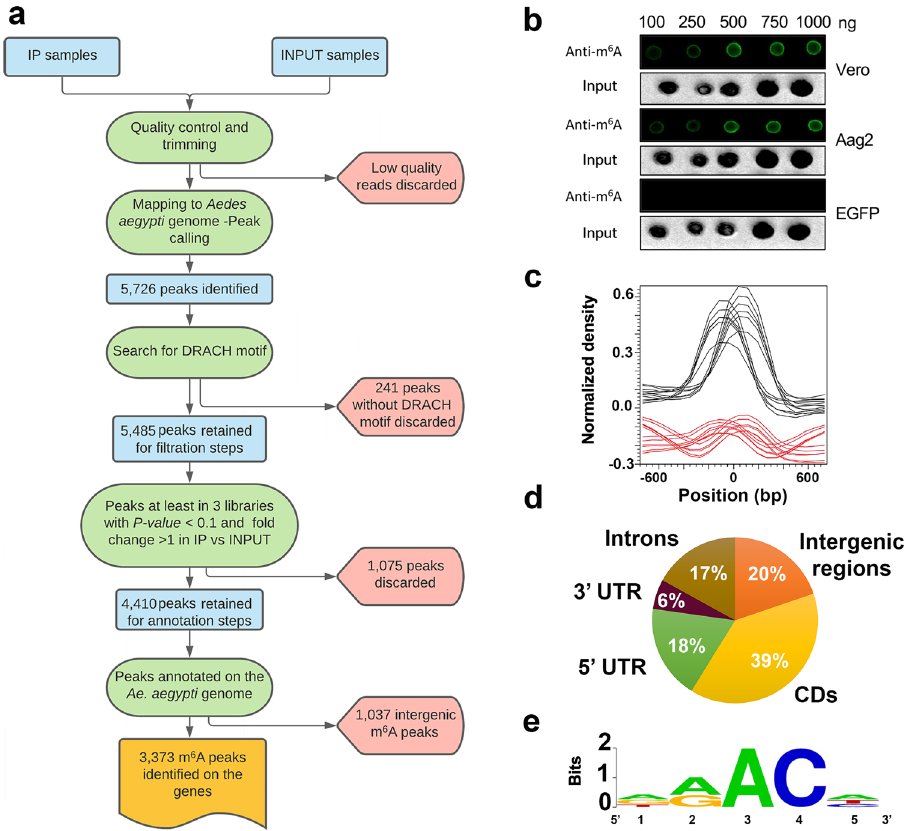
Fig. 1 m 6 A modi fi cation of Ae. aegypti transcripts analysed by dot blot and methylated RNA immunoprecipitation and sequencing (MeRIP-Seq). a A diagram showing the MeRIP-Seq data analysis procedure. b Con fi rmation of RNA N 6 -methyladenosine (m 6 A) methylation in Ae. aegypti . Total RNA from Aag2 and Vero cells were extracted and subjected to a dot blot assay using a speci fi c anti-m 6 A antibody. EGFP transcripts were synthetised in vitro and used as negative control. The input RNAs were directly stained with ethidium bromide. c Normalized density of m 6 A peaks between immunoprecipitated (black lines) and input (red lines) samples following MeRIP-Seq indicating enrichment of m 6 A in the IP samples as part of the quality control of the data. d Pie chart showing distribution of m 6 A peaks in Ae. aegypti transcripts regions. e The consensus m 6 A motif DRA*CH (D = G/A/U, R = G/A, * modi fi ed A, H = U/A/C) was enriched in the identi fi ed m 6 A